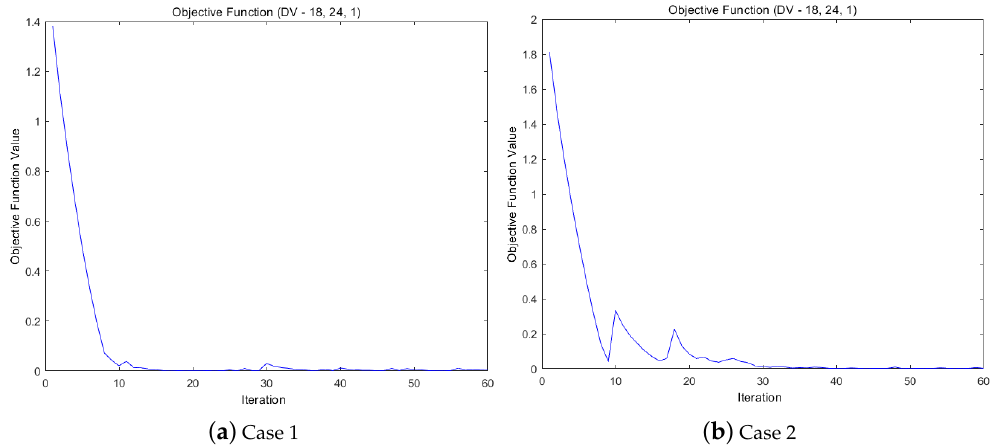
Figure 6. Objective function convergence for Cases 1 and